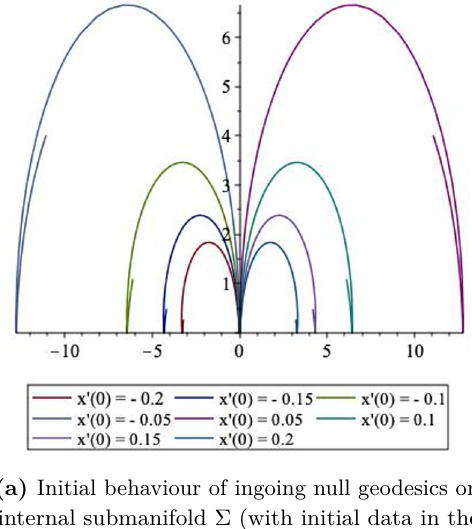
Figure 10. The AdS-cap curvature singularities at w = ± 1 in the upper half-plane Σ appear to be attractor-like for ingoing null